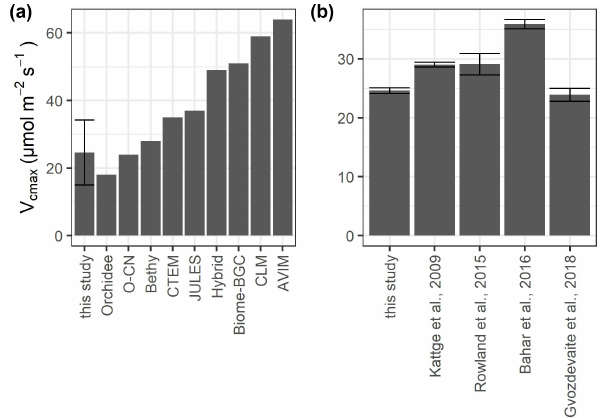
Figure 6. Values of V cmax at 25 ◦ C for sunlit upper-canopy leaves measured in this study compared to (a) different model estimates and (b) other lowland tropical sites growing on nutrient-poor ox- isols. The values for the models were adopted from Rogers (2014) for the plant functional types “broadleaf evergreen tropical tree” (Orchidee, O-CN, CLM, AVIM), “tropical tree (oxisol)” (Bethy), “rainforest” (Hybrid), “evergreen broadleaf tree” (Biome-BGC, CTEM), and “broadleaf tree” (Jules). We did not include IBIS, which was also mentioned in Rogers (2014), as the source of the data is unclear. Error bars in (a) show the standard deviation and in (b) the standard